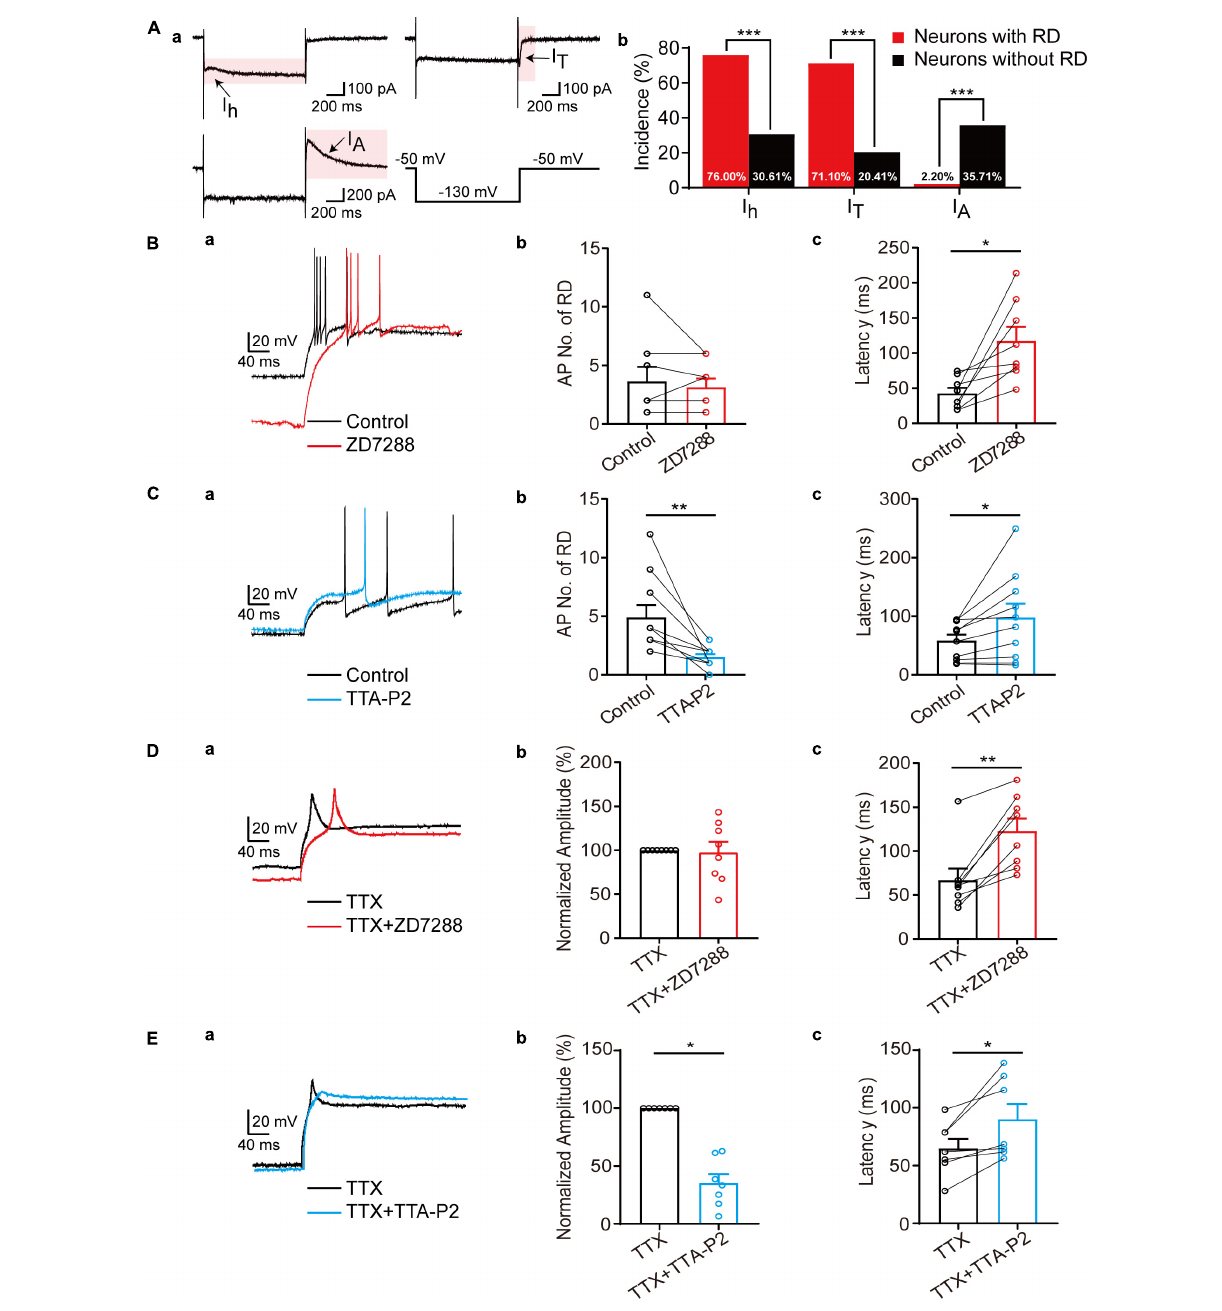
FIGURE 3 | Differential modulation of I h and I T to RD in SG neurons. (A) The subthreshold currents recorded from SG neurons. (a) Representative traces of the subthreshold currents (I h , I T , and I A ) recorded in SG neurons. (b) The subthreshold currents were differentially distributed among SG neurons with (red) or without (black). (B) RD in SG neurons was modulated by I h . (a) Representative traces of RD elicited by a hyperpolarizing current pulse ( − 120 pA, 1 s) in control (black) and with 10 µ M ZD7288 (red) in the absence of TTX. (b,c) . Summary of the blockage effect of ZD7288 on AP No. (b) and first spike latency of RD (c) in the absence of TTX. (C) RD in SG neurons was modulated by I T . (a) Representative traces of RD in control (black) and with 10 µ M TTA-P2 (blue) in the absence of TTX. (b,c) Summary of the blockage effect of TTA-P2 on AP No. (b) and first spike latency of RD (c) in the absence of TTX. (D) Effect of ZD7288 on RD of SG neurons in the presence of TTX. (a) Representative traces of RD response in TTX (black) and in TTX along with 10 µ M ZD7288 (red) in the presence of TTX. (b,c) Summary of the blockage effect of ZD7288 on AP No. (b) and first spike latency of RD (c) . (E) Effect of TTA-P2 on RD of SG neurons in the presence of TTX. (a) Representative traces of RD response in TTX (black) and in TTX along with 10 µ M TTA-P2 (blue) in the presence of TTX. (b,c) Summary of the blockage effect of TTA-P2 on AP No. (b) and first spike latency of RD (c) . RD, rebound depolarization; I h , hyperpolarization-activated cation current; I T , T-type calcium current; I A , A-type current; AP, action potential; TTX, tetrodotoxin. * p < 0.05, ** p < 0.01, *** p <